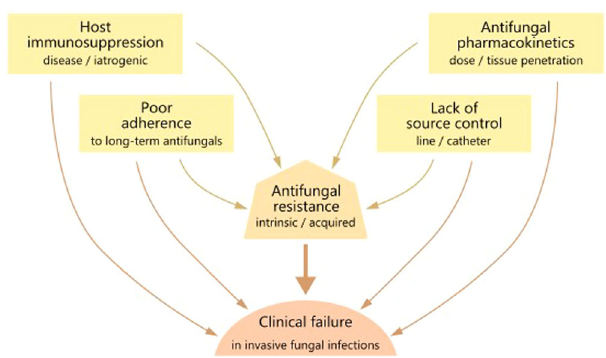
Fig. 2 | Factors mediating the contribution of antifungal resistance to clinical failure. All of the factorscontributing to clinicalfailureininvasivefungal infection are also drivers of antifungal